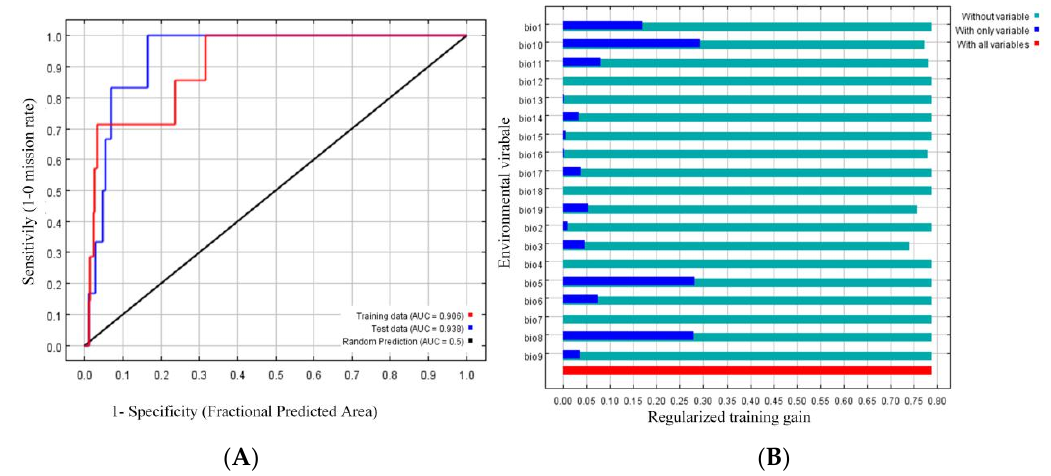
Figure 1. The receiver operating characteristic (ROC) curve ( A ) and jackknife test results ( B ) for the ancient P. orientalis distribution model. ( A ): The red and blue curves represent the training and test data, respectively, whereas the black line represents a random prediction; ( B ): Light blue bars correspond to no variables, dark blue bars correspond to only one variable, and red bars correspond to all variables.